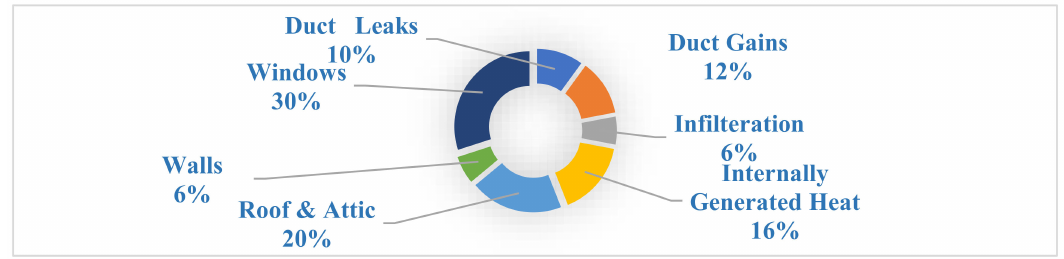
Figure 10. Cooling Load Sources.